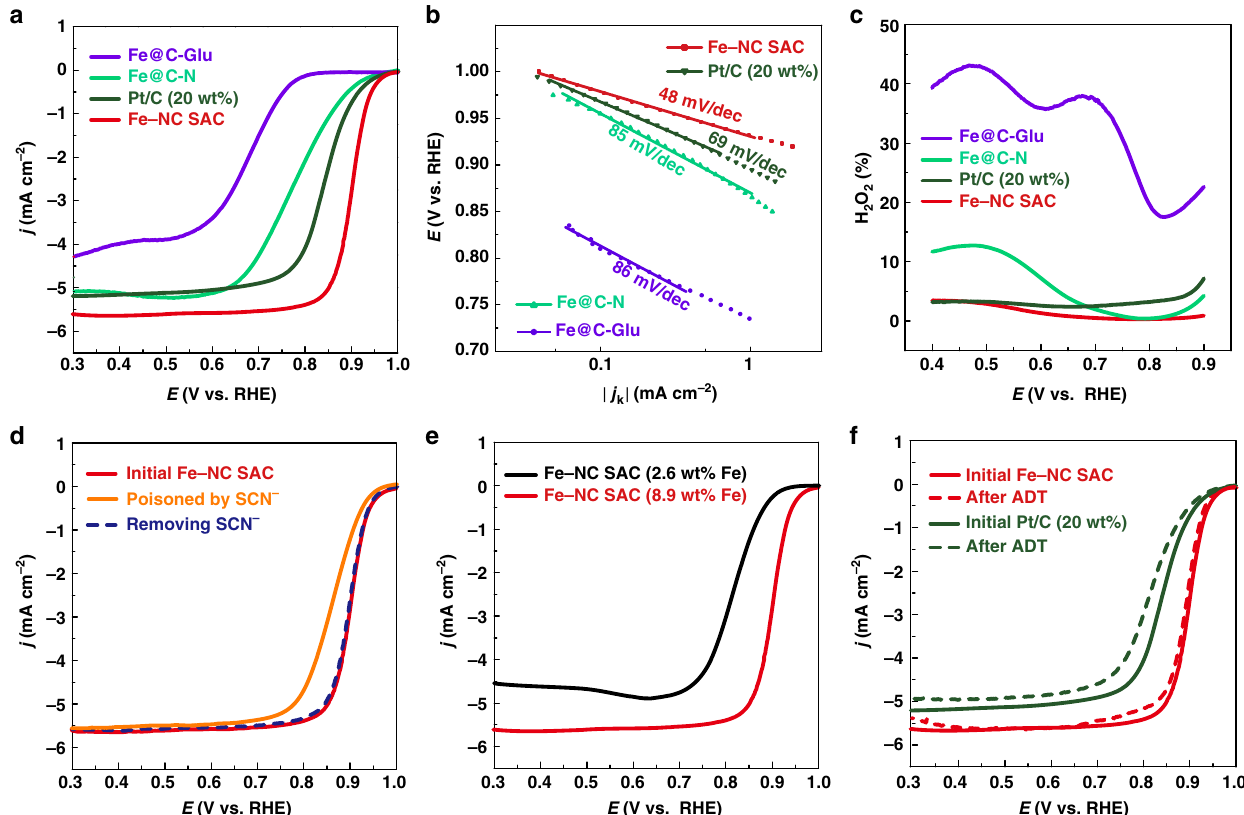
Fig. 5 Evaluation of electrocatalytic performance of Fe – NC SAC for ORR. a Steady-state ORR polarization curves of Fe – NC SAC, Pt/C and control samples (Fe@C – N and Fe@C-Glu). b Corresponding Tafel plots. c Hydrogen peroxide yield. d Steady-state ORR polarization curves of Fe – NC SAC recorded in O 2 - saturated 0.1 M KOH with or without poisoning by 0.01 M SCN − , and one collected after removing SCN − . e Steady-state ORR polarization curves of Fe – NC SAC with different Fe loading. f Steady-state ORR polarization curves of Fe – NC SAC and Pt/C before and after 5000 potential scanning cycles in O 2 - saturated 0.1 M